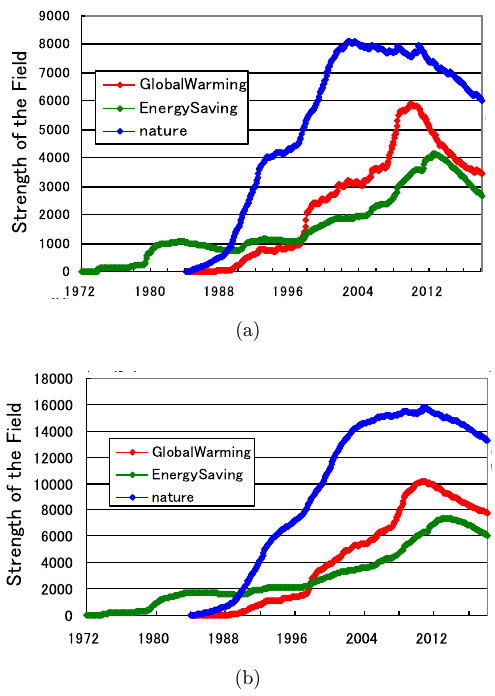
Fig. 7. Time-varying strength of the ¯eld of information environment for the cases of oblivion functions of (a) the power-law type and (b) the exponential